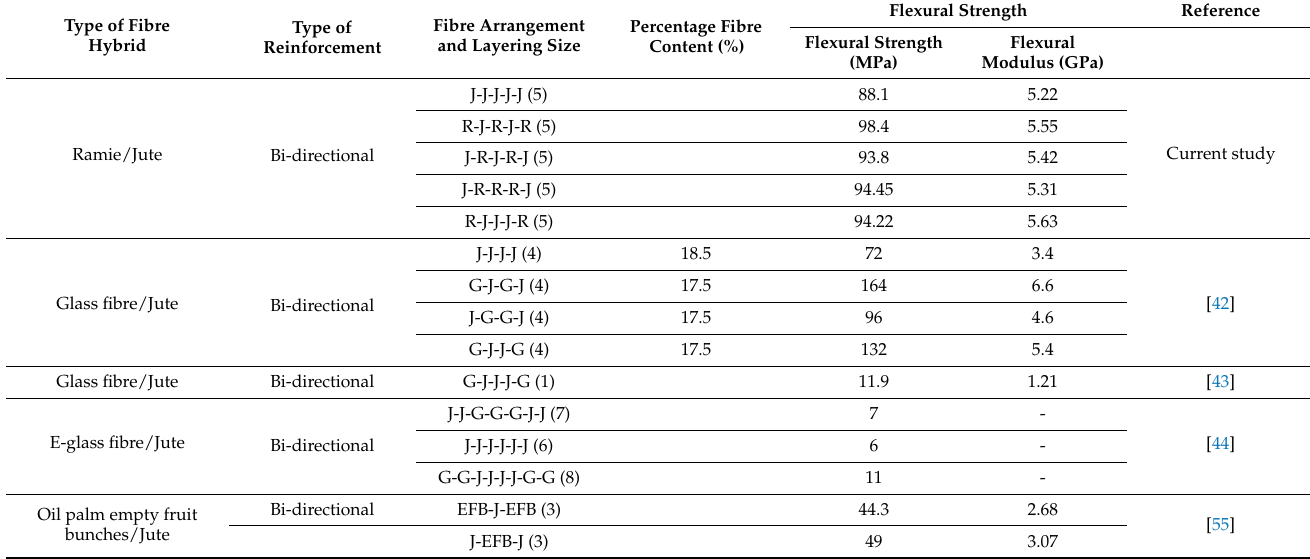
Table 6. Comparison of flexural properties of hybrid composite reinforced